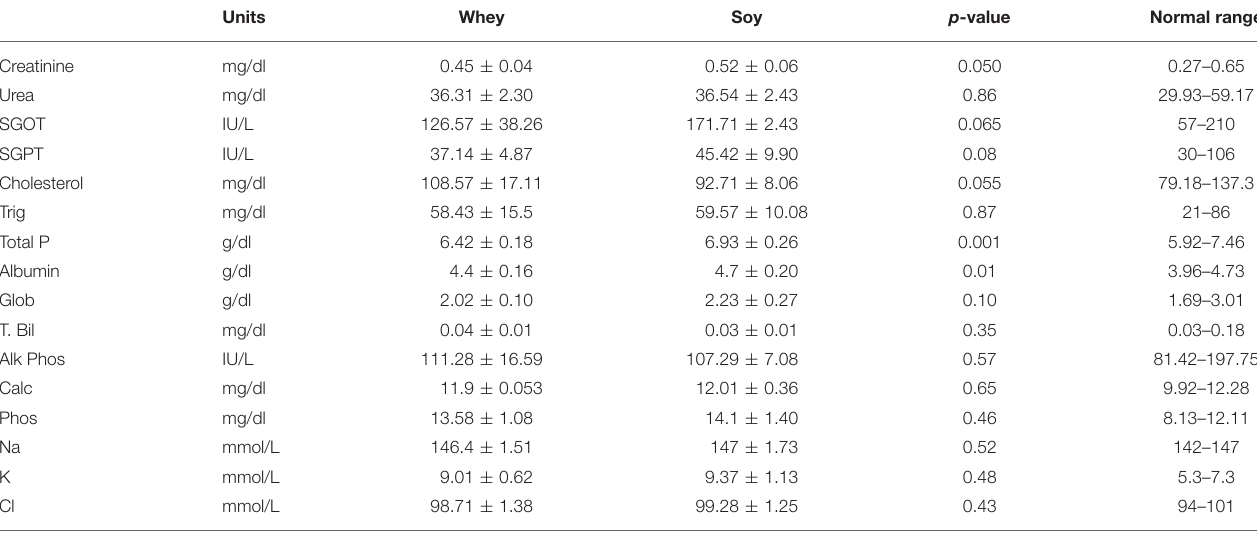
TABLE 1 | Serum analysis in male rats after 74 days with soy or whey diets (values are presented as average ± SD). Units Whey Soy p -value Normal range